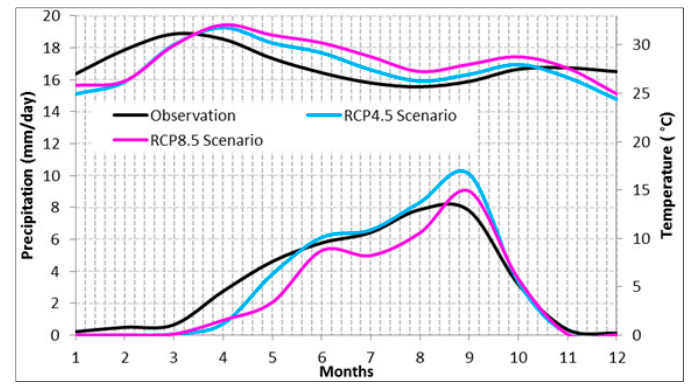
Figure 4. Daily mean precipitation and temperature.